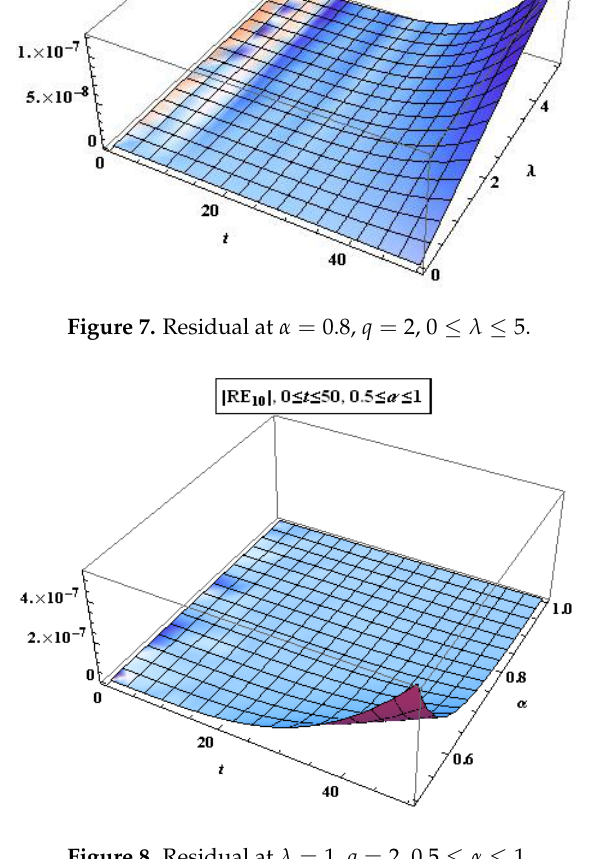
Figure 8. Residual at λ = 1, q = 2, 0.5 ≤ α ≤ 1.